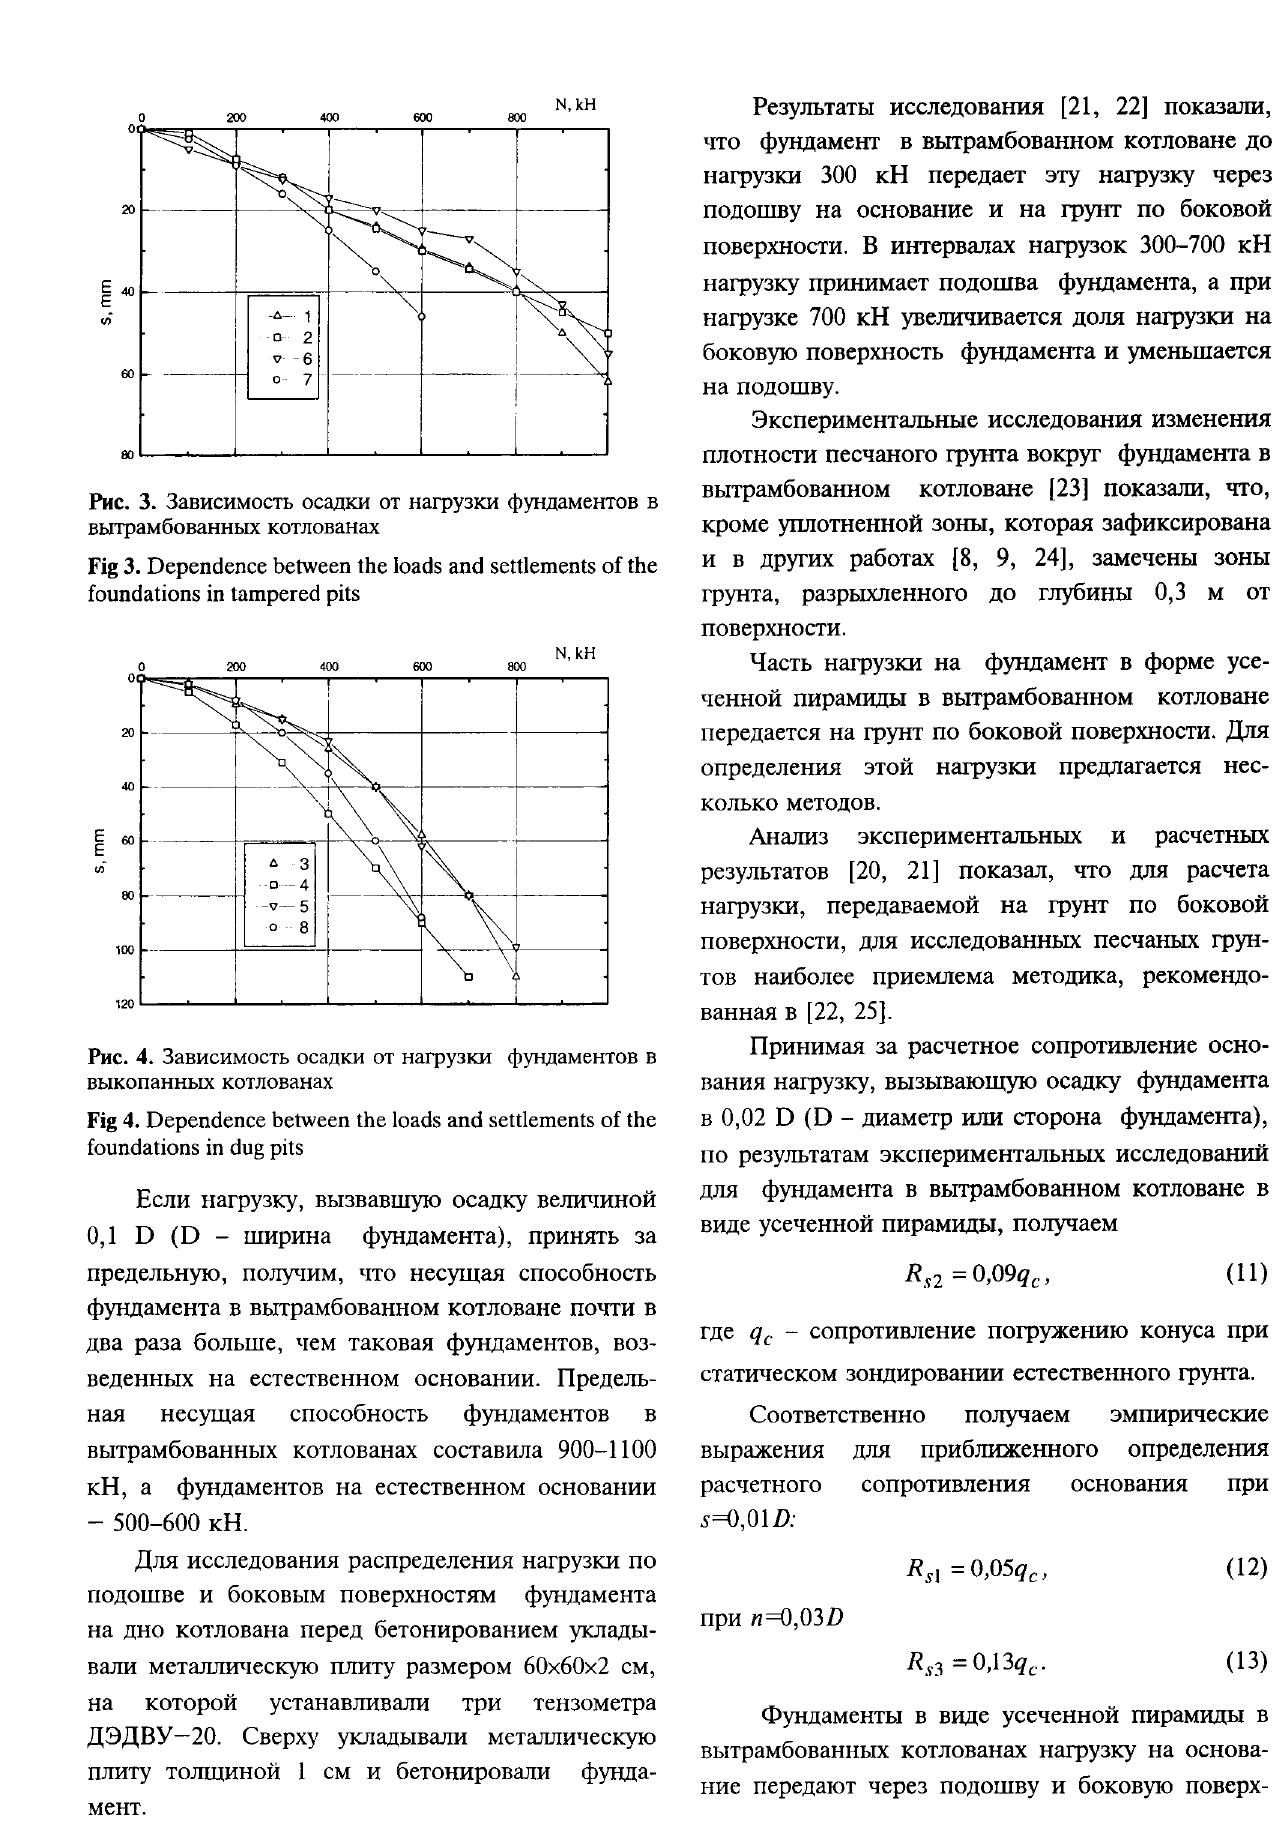
Fig 3. Dependence between the loads and settlements of the foundations in tampered pits